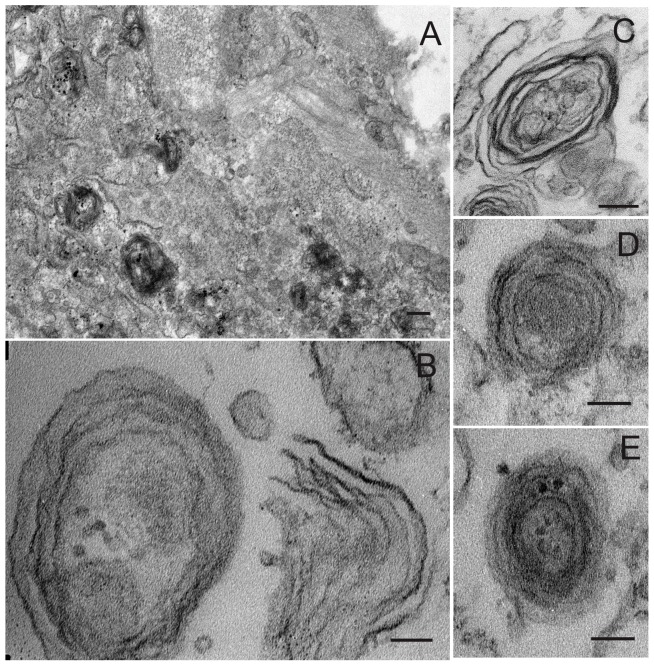
Ultrastructure of ATII-LCs.Transmission electron micrographs of differentiated ATII-LCs. A) Presence of numerous electron-dense cytoplasmic organelles and cell surface associated structures, probably microvilli. (x20,000; scale bar  = 200 nm). B) Membranous structures containing multiple concentric lamellae (left) and one partially unraveled fragmented lamellar body-like complex (right), displaying numerous unpacked membranes (x 120,000; scale bar  = 50 nm) C–E) Individual membranous structures with ellipsoid (C) or circular (D, E) shapes and a multilamellar ultrastructure (x 40000, scale bar  = 200 nm).